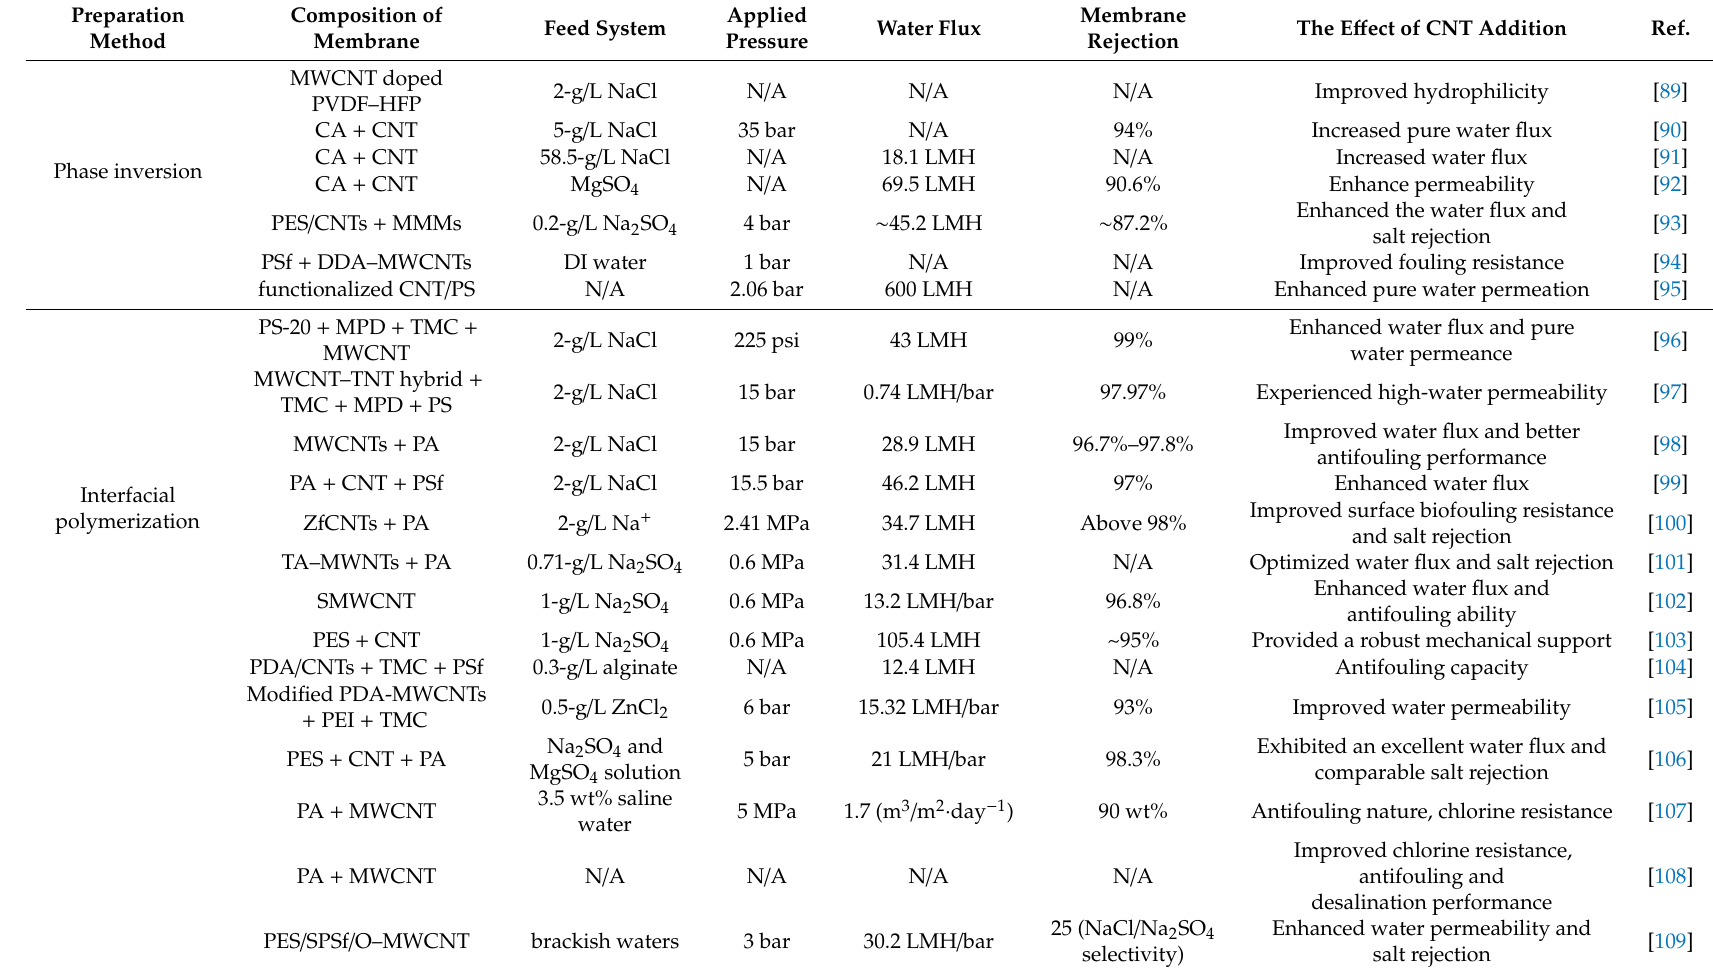
Table 1. Summary of the performance evaluation of di ff erently composited CNT membranes for